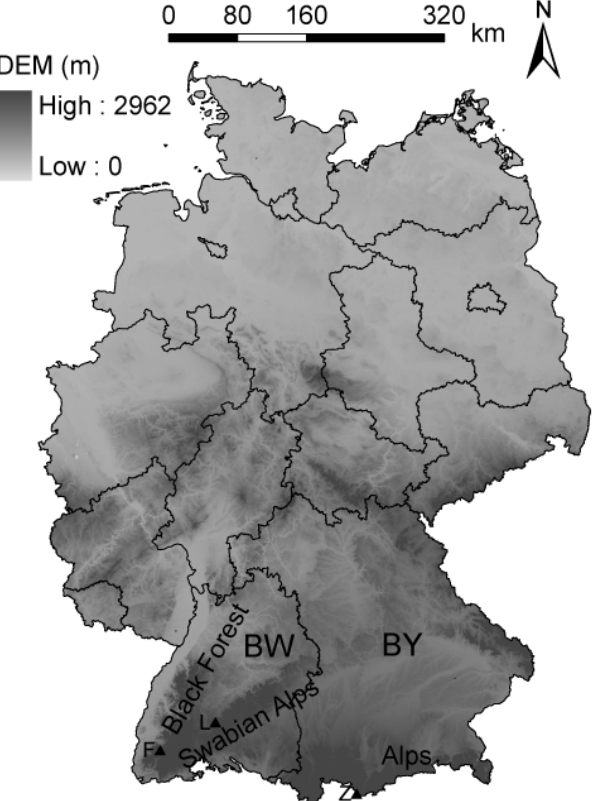
Fig. 1. Study areas (F, L and Z are the local peeks Feldberg, Lem- berg and Zugspitze in the study areas,